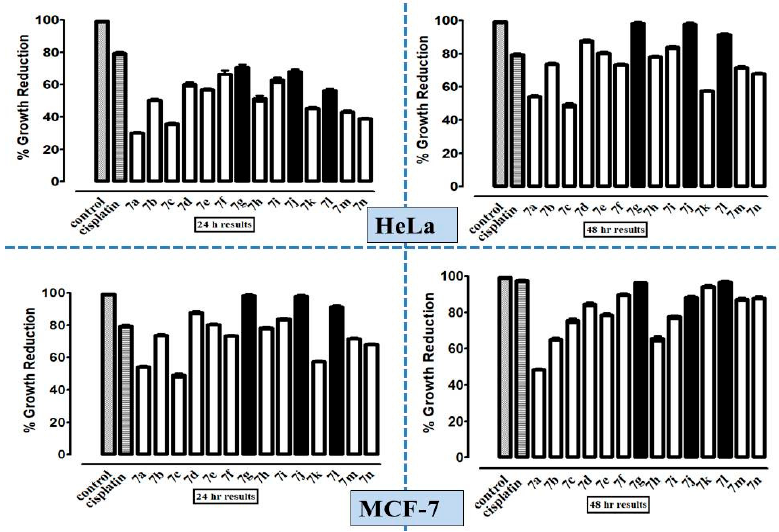
Figure 16. The depiction of % growth reduction of HeLa and MCF-7 cell lines by 1, 3, 4oxadiazoles derivatives. The results were measured for 24 h and 48 h.